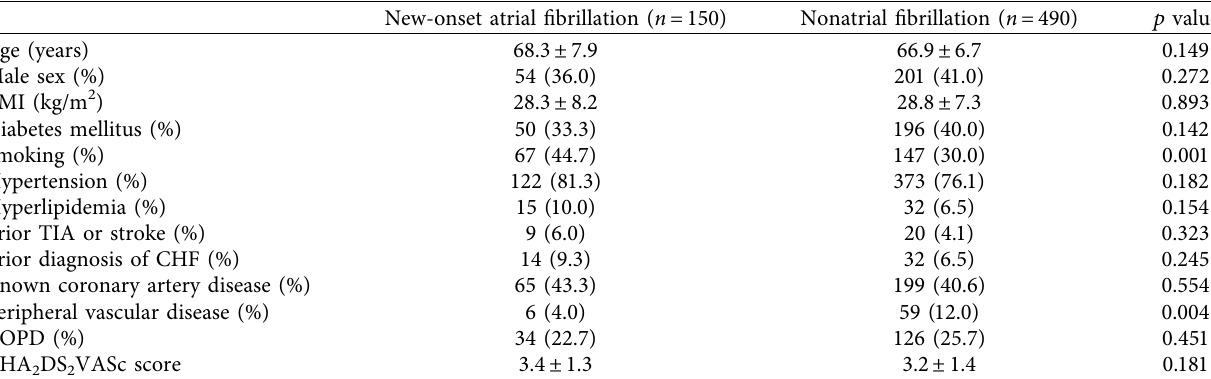
Table 1: Demographic characteristics.